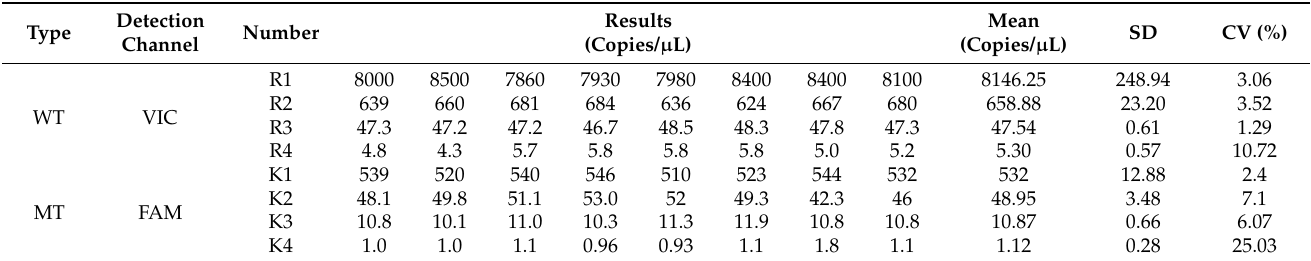
Table 2. dd PCR detection repeatability of the R294K mutation in WT and MT plasmids. Detection Type Channel